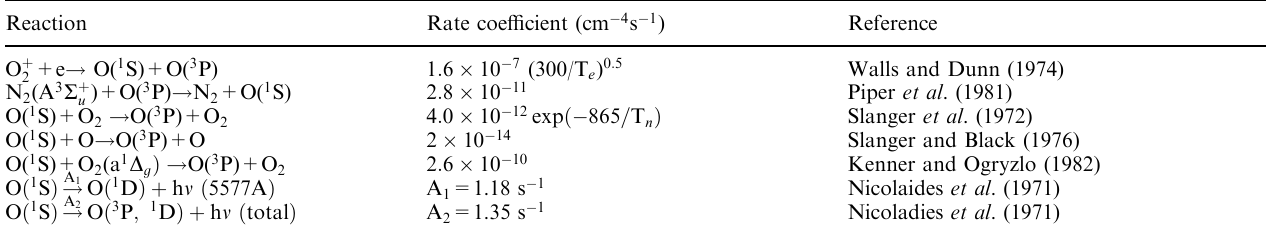
Table 1 Reactions and rate coe(cid:129)cients